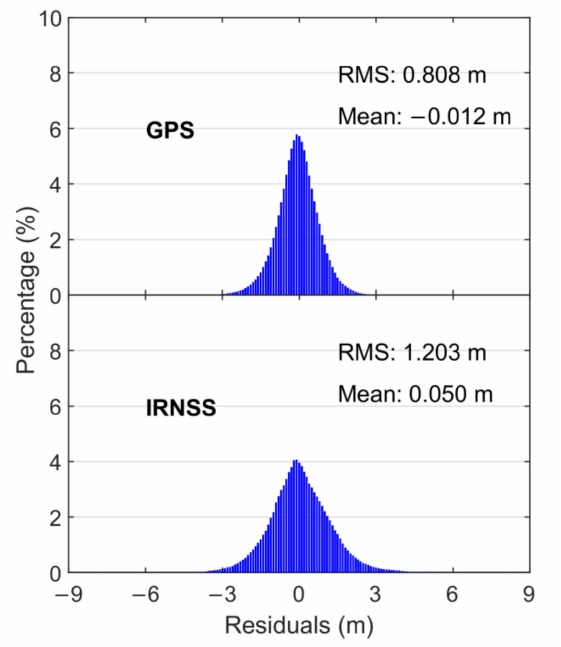
Figure 12. Distribution of code observation residuals derived from GPS/IRNSS combined SPP for GPS and IRNSS